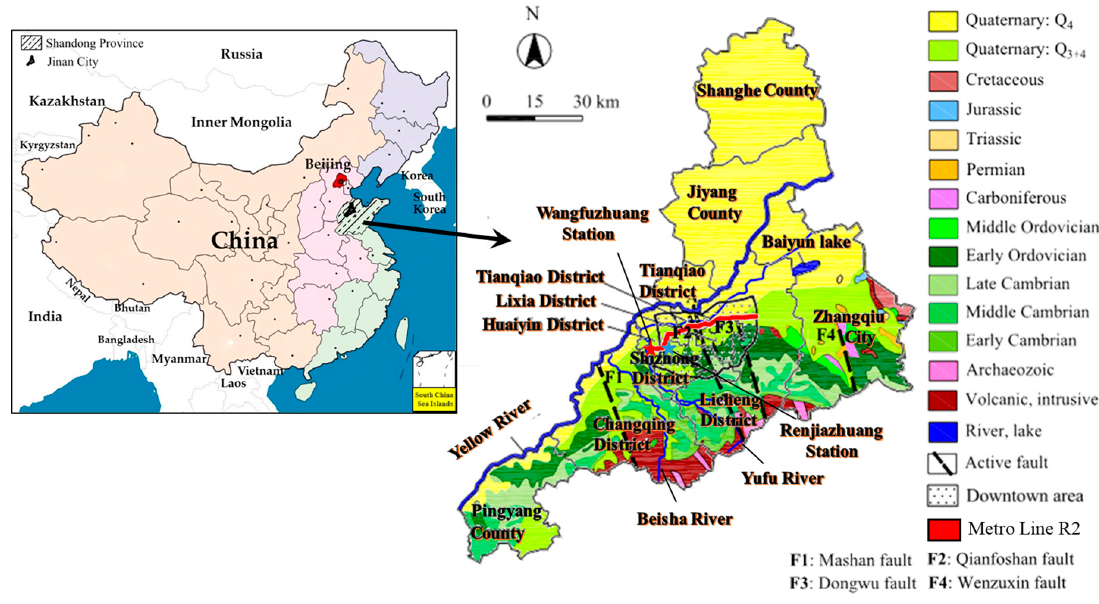
Figure 13. Plan view of the district division and geology in Jinan [26].